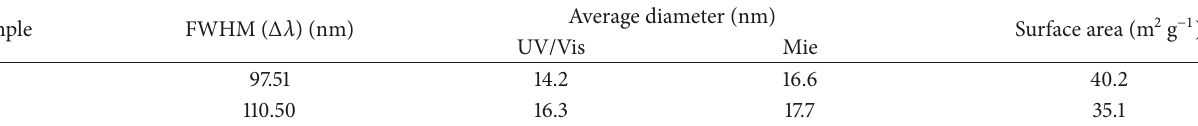
Table 2: Ag NP sizes evaluated using UV-Vis spectroscopy and using Mie’s theory.